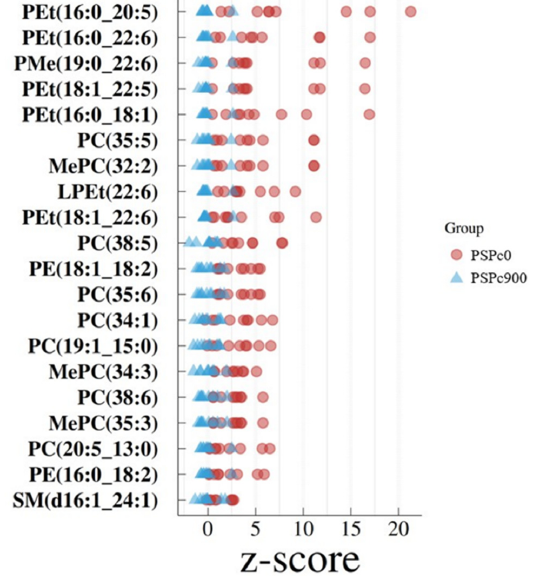
Figure 2. The Z-score plot of liver differential lipid metabolites of juvenile American eels in the PSPc0 group and PSPc900 group. Table 5. The differential lipid metabolites in the liver of juvenile American eels in the PSPc0 group and PSPc900 group.